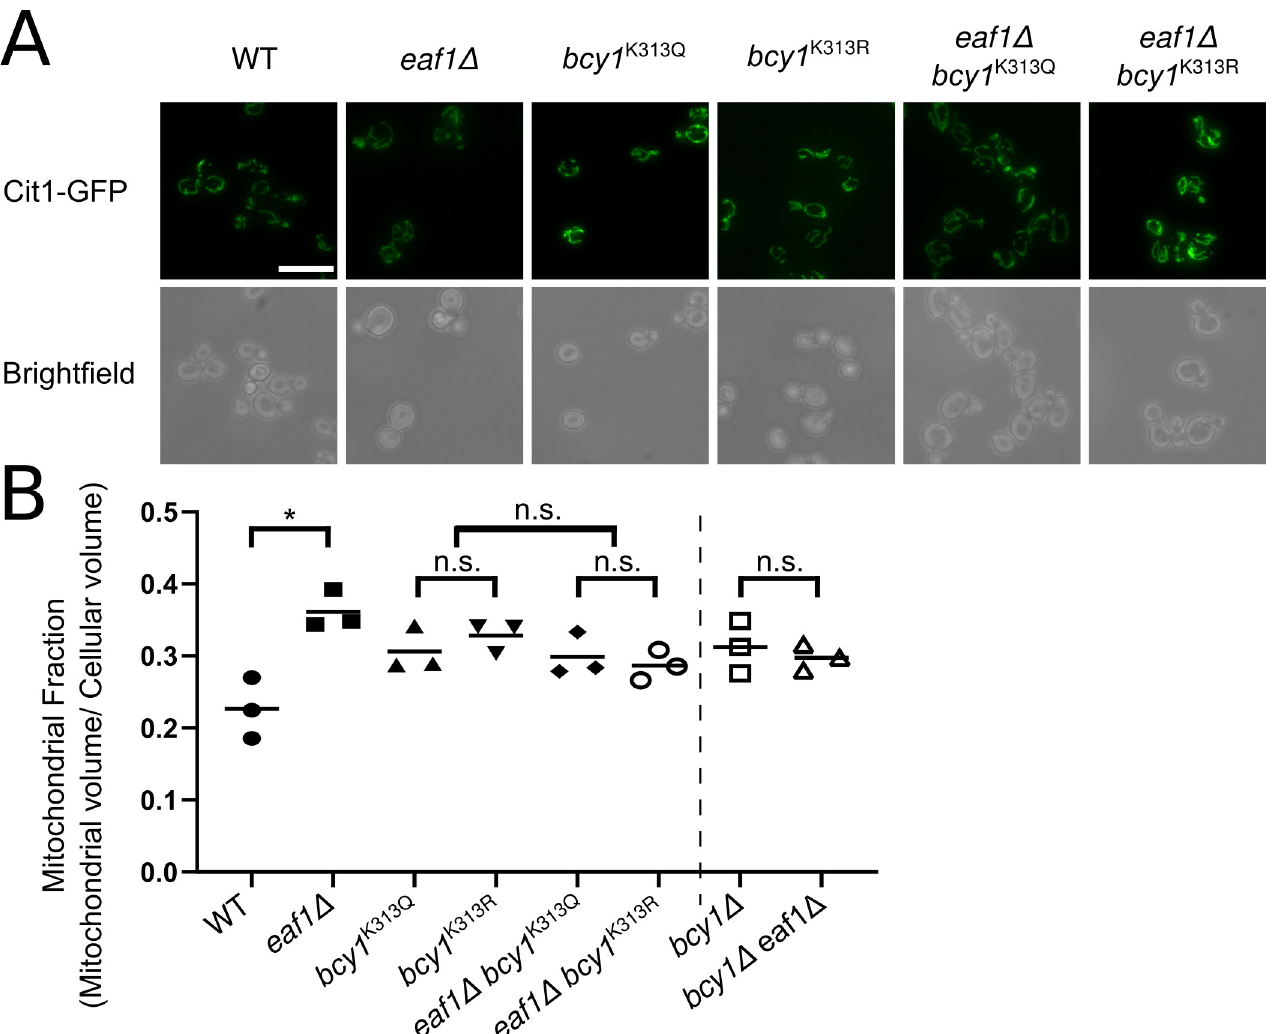
Fig 7. Assessment of mitochondrial volume in Bcy1-K313Q/R mutants. ( A) The mitochondrial structure and volume were assessed in the indicated strains expressing the mitochondrial marker Cit1-GFP. Scale bar = 10 μ m. (B) The mitochondrial volume was quantified based on the Cit1-GFP fluorescence using the MitoMap plugin for ImageJ which was then divided by the average total cellular volume of the strain to give the Mitochondrial Fraction (Raw cellular and mitochondrial volume measurements can be found in S7 and S8 Figs). Images are representative of 3 independent biological replicates and at least 50 cells per replicate were analyzed for quantification. This volume was compared to previously calculated bcy1 Δ and bcy1 Δ eaf1 Δ mitochondrial volume measurements (x- axis break represents experiments previously shown in Fig 5). ANOVA analysis was performed with a Tukey’s multiple comparison test comparing pairs of means. � = p < 0.05, n.s. = p > 0.05, relevant significance bars shown. Horizontal bars in the data represent the mean.